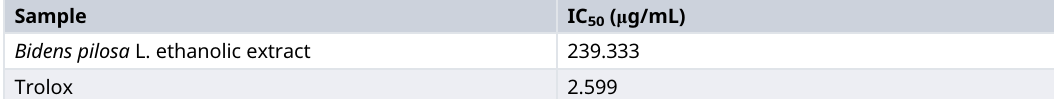
Table 9. Comparison of inhibition coefficients for Bidens pilosa L. and Trolox.